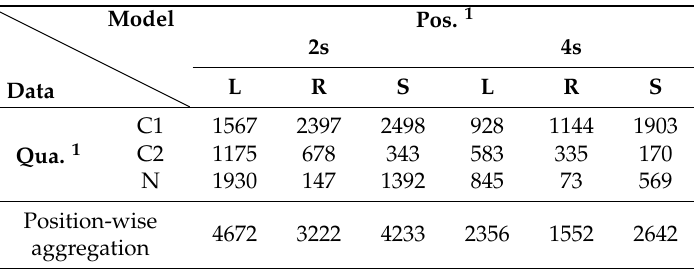
Table 1. Description of the data used in training and model evaluations.